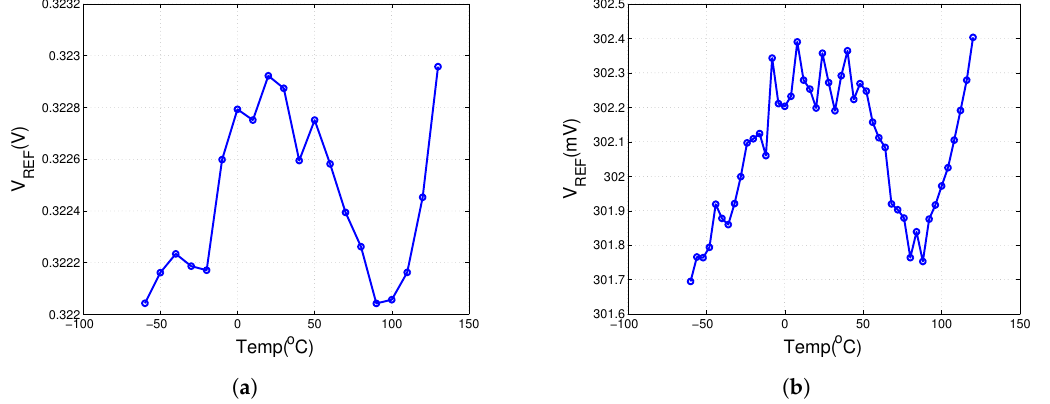
Figure 3. Measured temperature coefficient (TC) of the two reference circuits. ( a ) Measured TC of 15 ppm/ ◦ C of the first reference circuit; ( b ) measured TC of 12.9 ppm/ ◦ C of the second reference